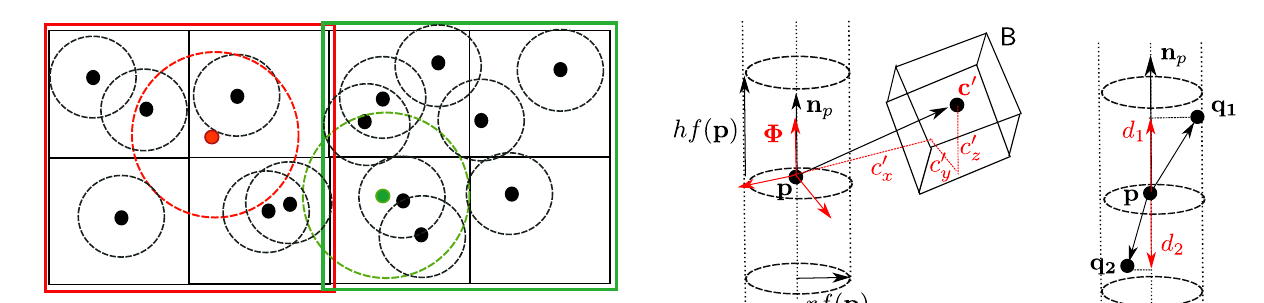
Figure 2: Visualization for the criterion assigning points to the octree. Circles mark the point-wise GSD, points represent the coordinates. Points are assigned to the box they are located in and the side lengths of the box are comparable to the GSD.